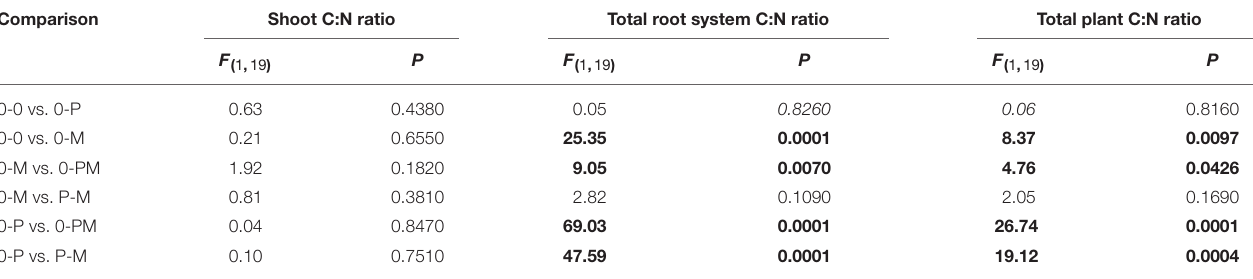
TABLE 4 | F - and P -values of GLM contrasts showing treatment effects on the C:N ratio of Triticum aestivum shoots, the total root system, and of whole plants.